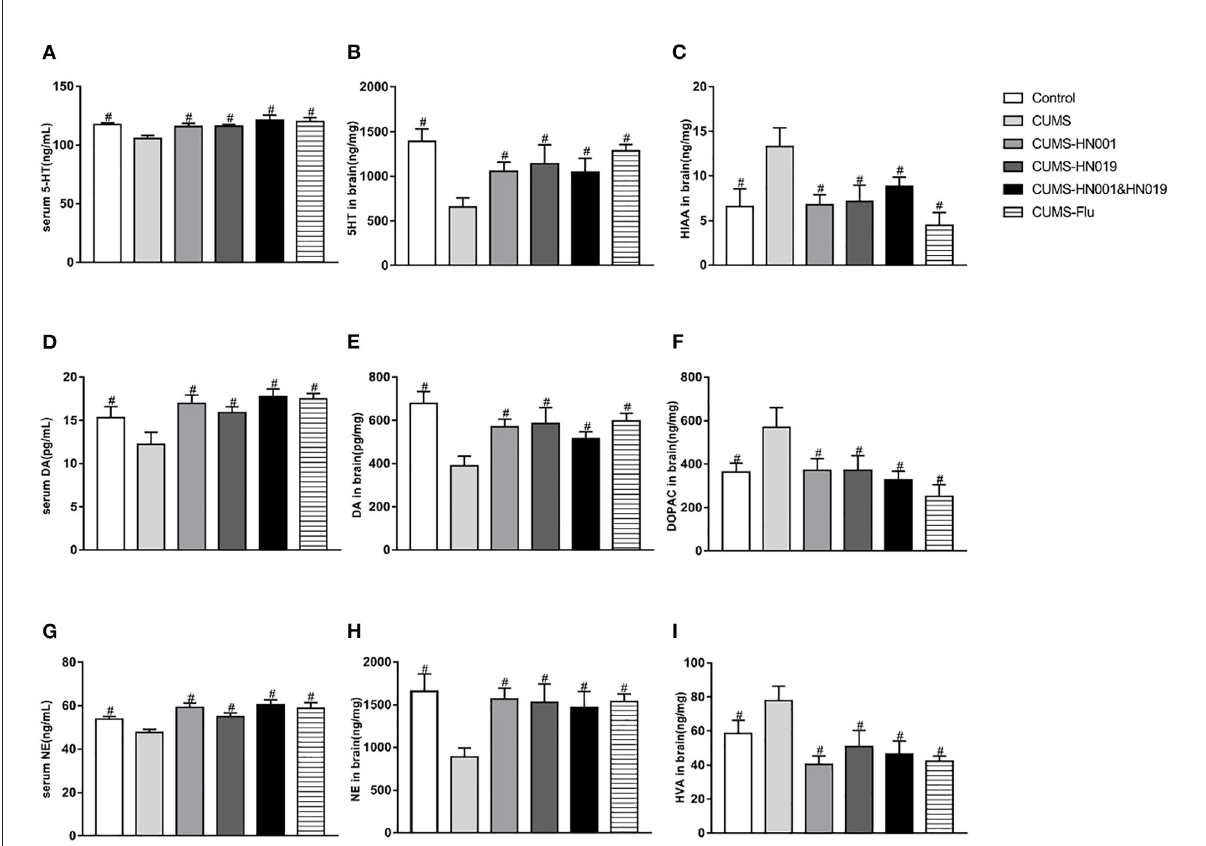
FIGURE4 Probiotics normalized CUMS-induced changes in neurotransmitters and their metabolite in rat serum and brain. The level of serum and brain 5-HT, DA and NE were detected at the end of the experiment (A,B,D,E,G,H) . (C , F , I) showing metabolite of monoamine neurotransmitters in brain. The results are presented as the Mean ± SEM ( n = 9-10 in serum, n = 6 in brain). # p < 0.05 compared with CUMS